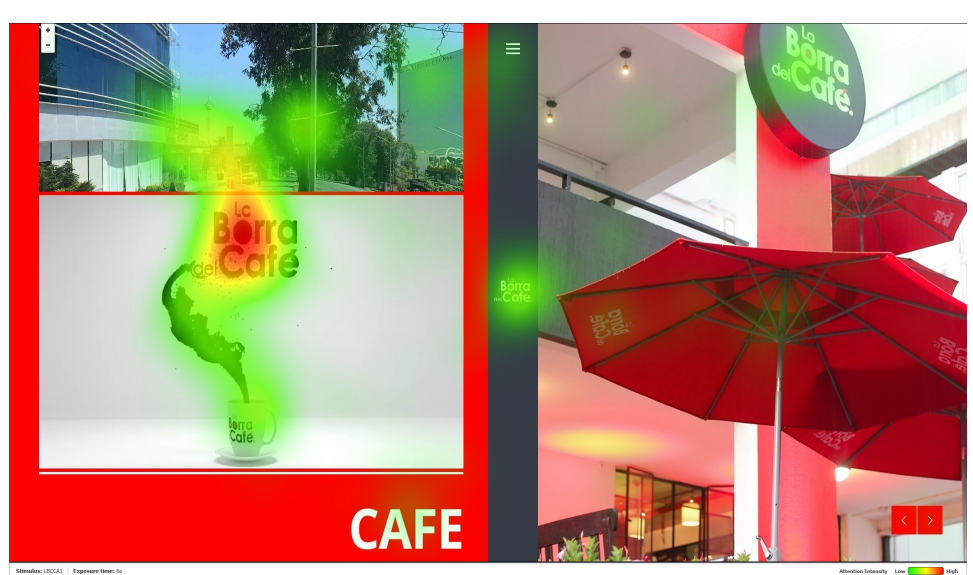
Figure 6. New website design: heat